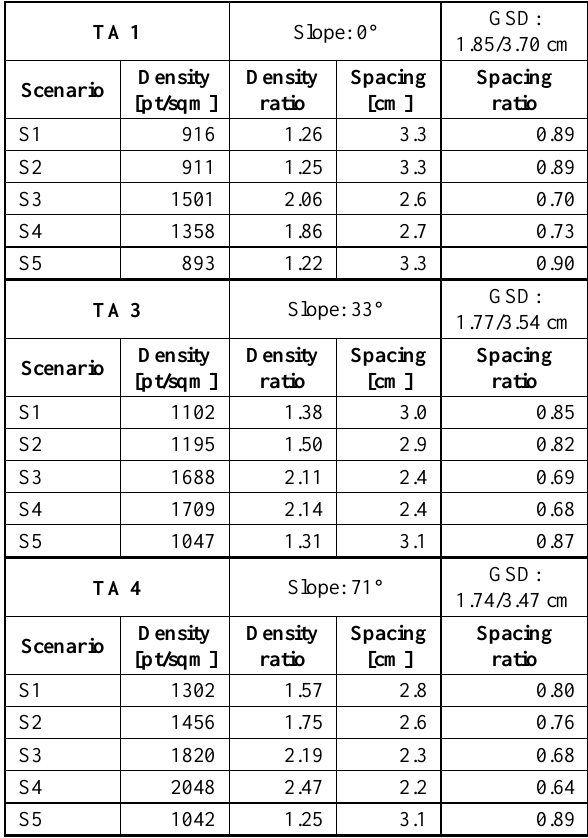
Table 7. Detailed analysis of point density